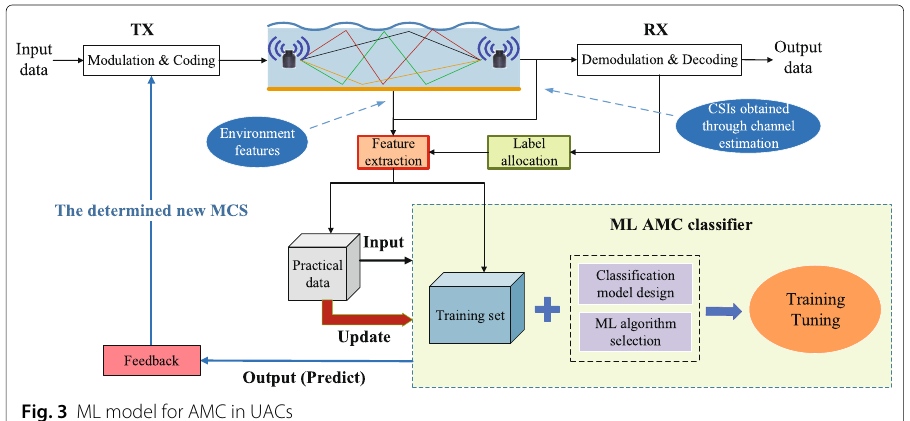
Fig. 3 ML model for AMC in